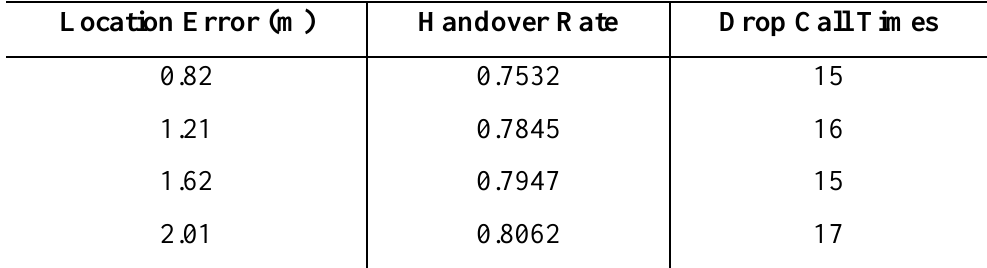
Table 2. Handover rate and outage times over various localization errors.